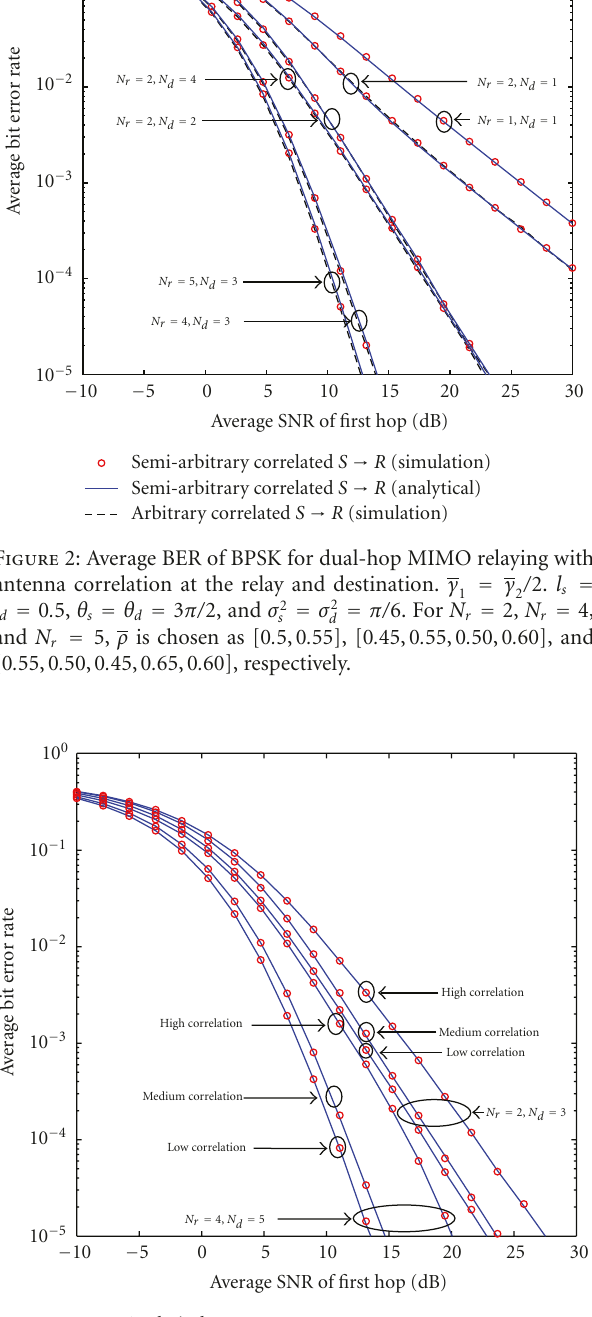
, l d = m = π/ 6). Here, , l d = 0 . 8, σ 2 d l = [0 . 2,0 . 3] for N = 2, r l = [0 . 55,0 . 45,0 . 4,0 . 5], ρ = m l